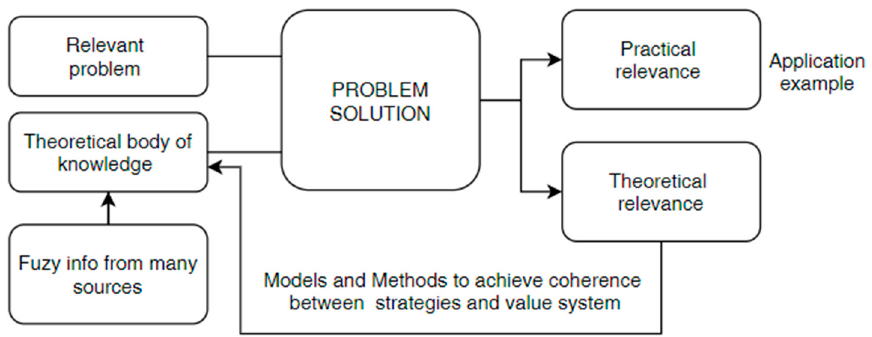
Figure 1. Constructive research methodology.